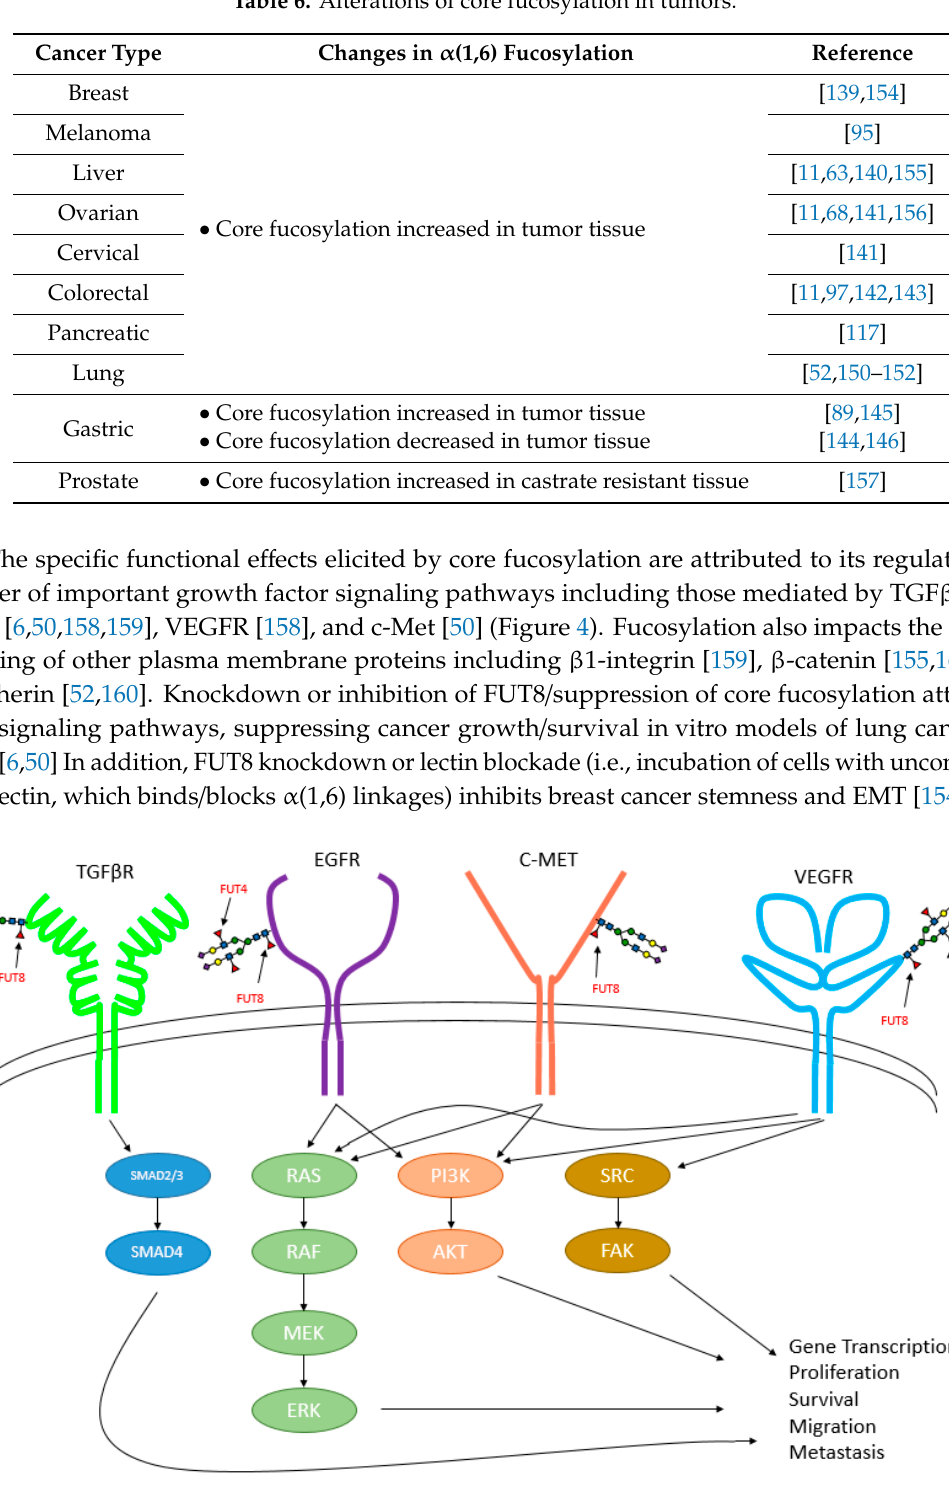
Figure 4. Growth factor signaling pathways known to be regulated by fucosylation.